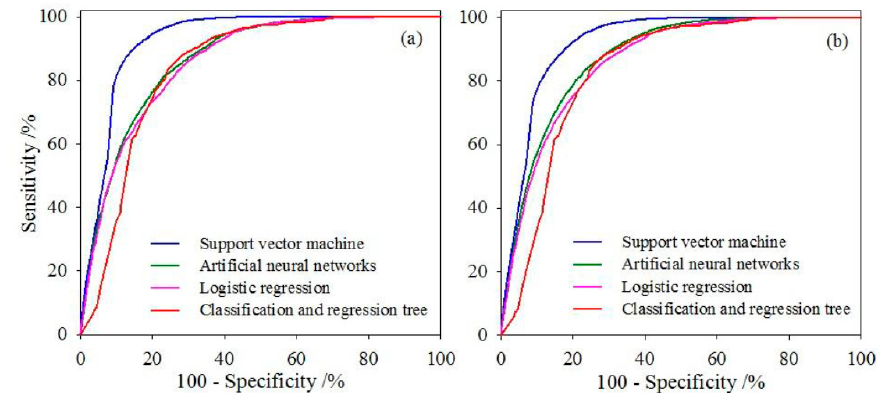
Figure 5. The receiver operating characteristic (ROC) curves of the SVM, ANN, LR, and CART models in landslide susceptibility assessment: ( a ) training and ( b ) verifying.